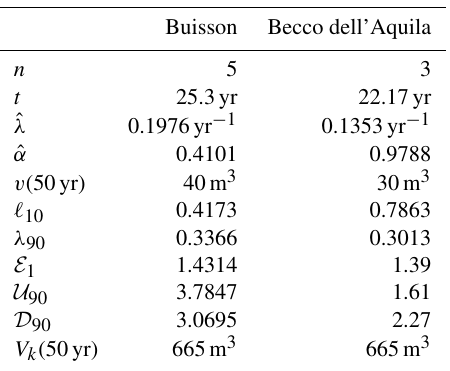
Table 1. Error calculations for Buisson and Becco dell’Aquila at T = 50 years, supposing p =